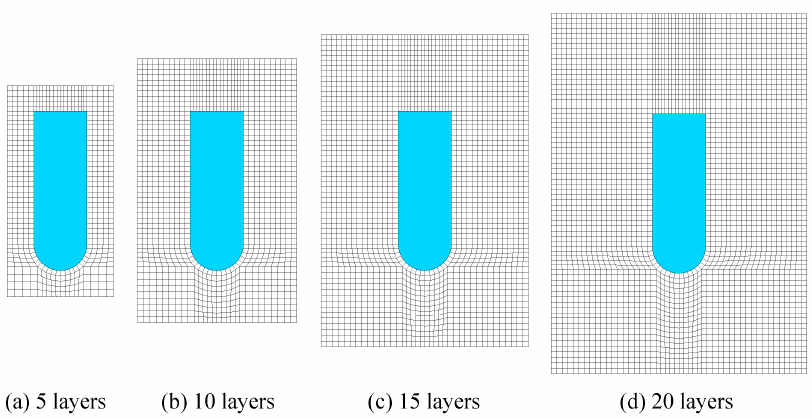
= 5 , 𝑁 = 10 , 𝑁 = 15 and 𝑁 = 20 ) in over- (cid:3008)(cid:3013) (cid:3008)(cid:3013) (cid:3008)(cid:3013) (cid:3008)(cid:3013)